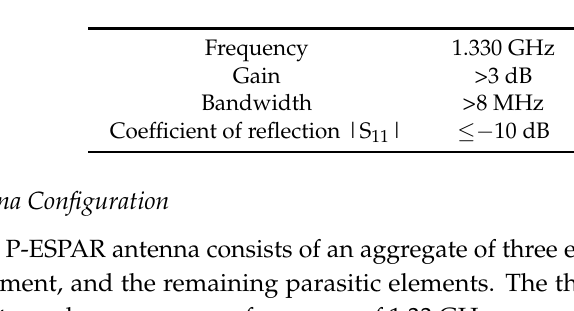
Requirements for the planar electrically steerable passive array radiator (P-ESPAR) antenna design.